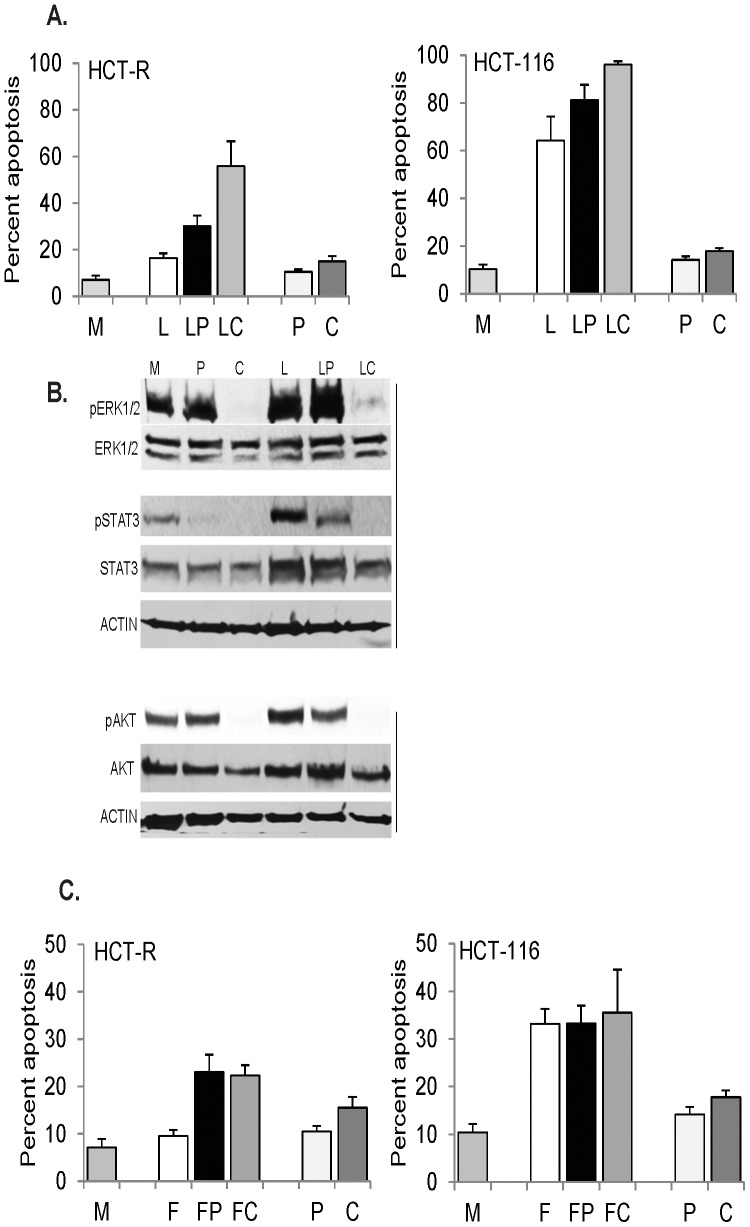
Ability of ICAP and propolis to augment chemotherapeutics-induced apoptosis.A. HCT-R or HCT-116 cells were exposed for 48 h or 24 h respectively, to mock (M), 50 nM LBH589 (L), LBH589 and 100 µg/ml propolis (LP), LBH589 and the ICAP (LC), 100 µg/ml propolis (P), or the ICAP alone (C). B. HCT-R cells were exposed to the treatments described in A for 17 h. and total cell lysates were analyzed by western blotting. C. HCT-R and HCT-116 cells were exposed for 48 h or 24 h respectively, to mock (M), 10 µM 5-fluorouracil (F), 5-fluorouracil and 100 µg/ml propolis (FP), 5-fluorouracil and the ICAP (FC), propolis (P), or the ICAP alone (C).